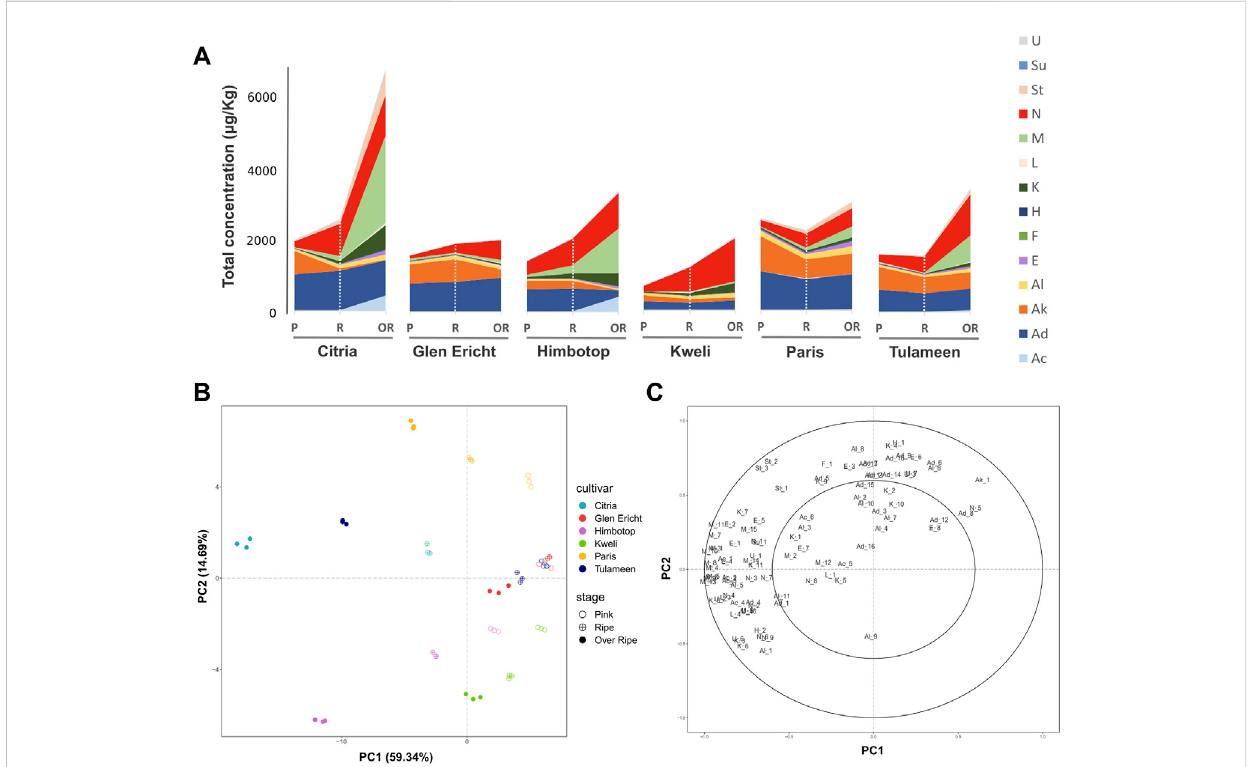
FIGURE 1 Evolution of raspberry VOC pro fi le during fruit ripening assessed by SPME/GC-MS analysis. The stacked area chart reported in the plot (A) illustrates the total VOC concentration, expressed as μ g/L of 2-octanol, for each raspberry cultivar ( “ Citria ” , “ Glen Ericht ” , “ Himbotop ” , “ Kweli ” , “ Paris ” , and “ Tulameen ” )atthreeripeningstages[pink(P),ripe(R),andoverripe(Or)].EachVOCclasses[acids(Ac),aldehydes(Ad),alkenes(Ak),alcohols(Al),esters(E), furans (F), hydrocarbons (H), ketones (K), lactones (L), monoterpenes (M), norisoprenoids (N), sesquiterpenes (St), sulfurs (Su), unknowns (U)] is